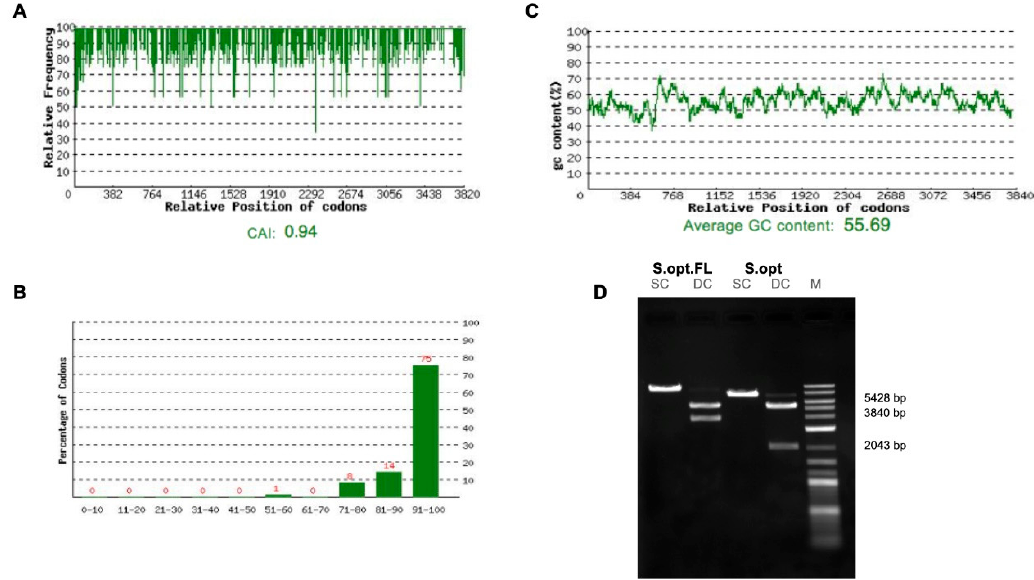
Figure 2. Optimizations of the full-length SARS-CoV-2 spike gene. ( A ) Distribution of codon usage frequency of the spike gene. Codon Adaptation Index (CAI) = 0.94. ( B ) Codon distribution percentage computed as codon quality group. ( C ) GC content adjustment with average equal to 55.69. ( D ) Restriction analysis for the S.opt.FL and S1.opt using single-cut digestion with BamH I and double-cut digestion with BamH I and Nhe I.